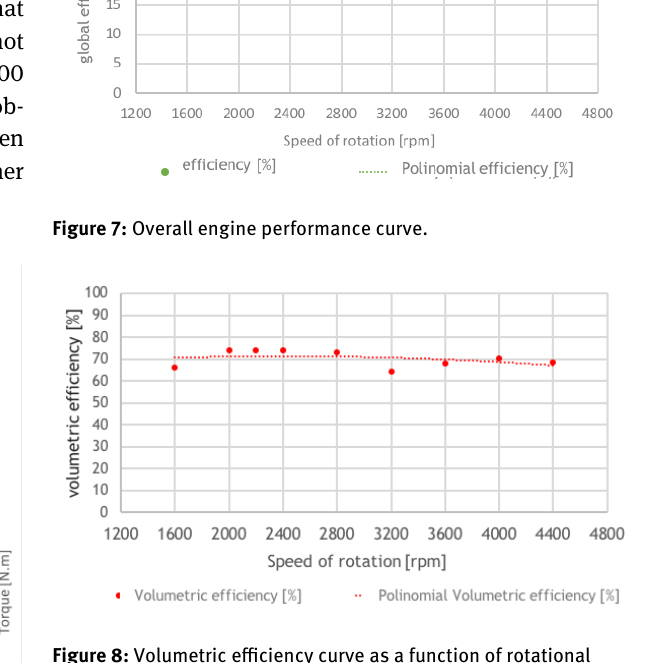
Figure 8: Volumetric eflciency curve as a function of rotational